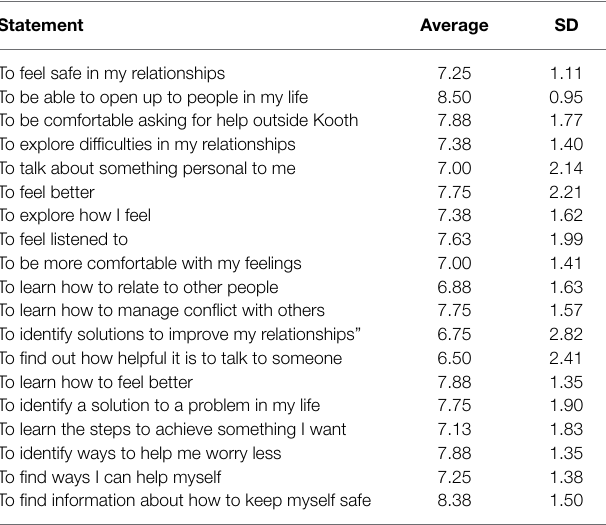
TABLE 4 | Average score for each item’s survey